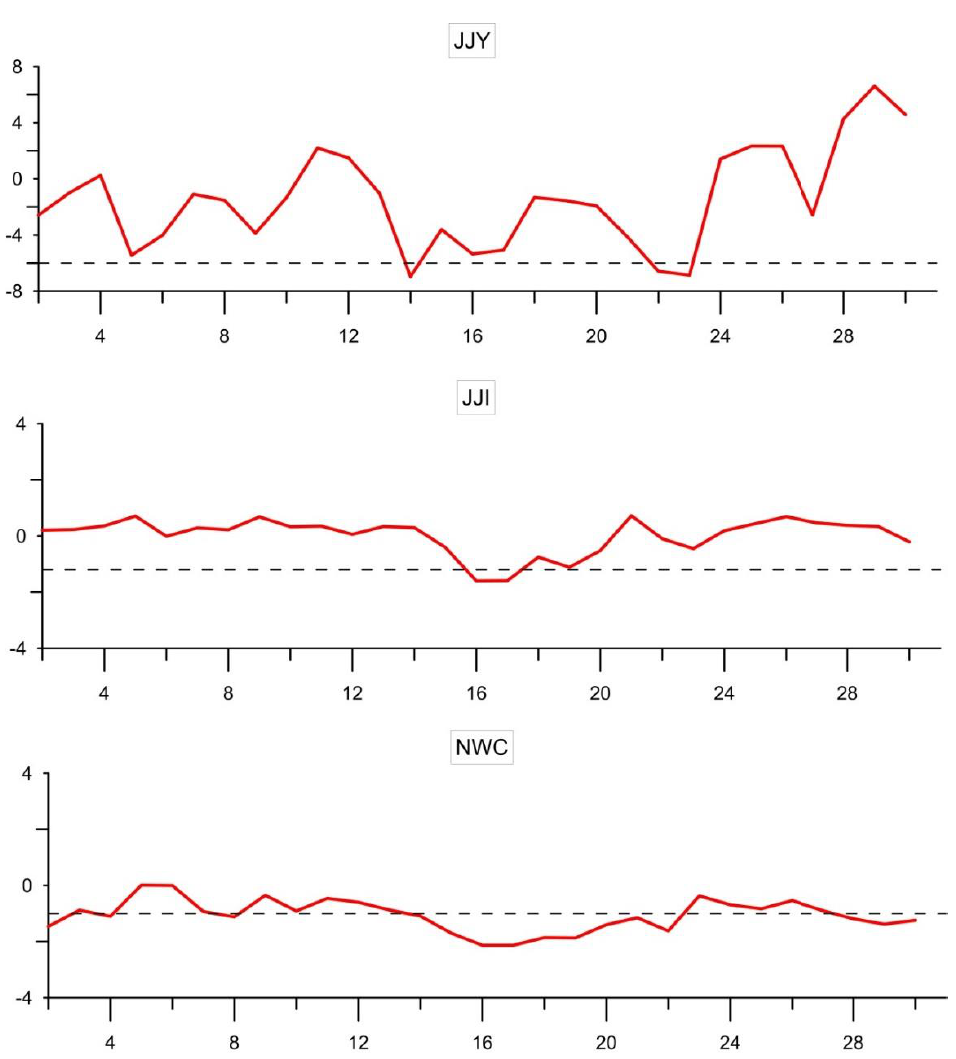
Figure 15. Same as in Figure 14, but for the second March EQ. Three daily variations of signal amplitudes for the three propagation paths of JJI-PTK (first panel), JJI-PTK (second panel), and NWC-PTK (bottom panel). The ordinate is signal amplitude in relative unit (red), and the horizontal lines are all − 2 sigma level for each propagation path.